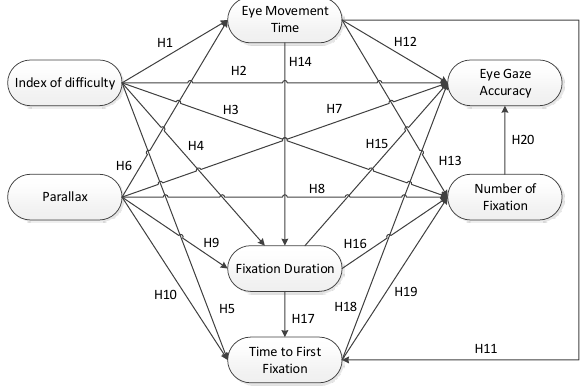
Fig.2. The SEM hypothesis constructs for eye movement pa- rameters in stereoscopic